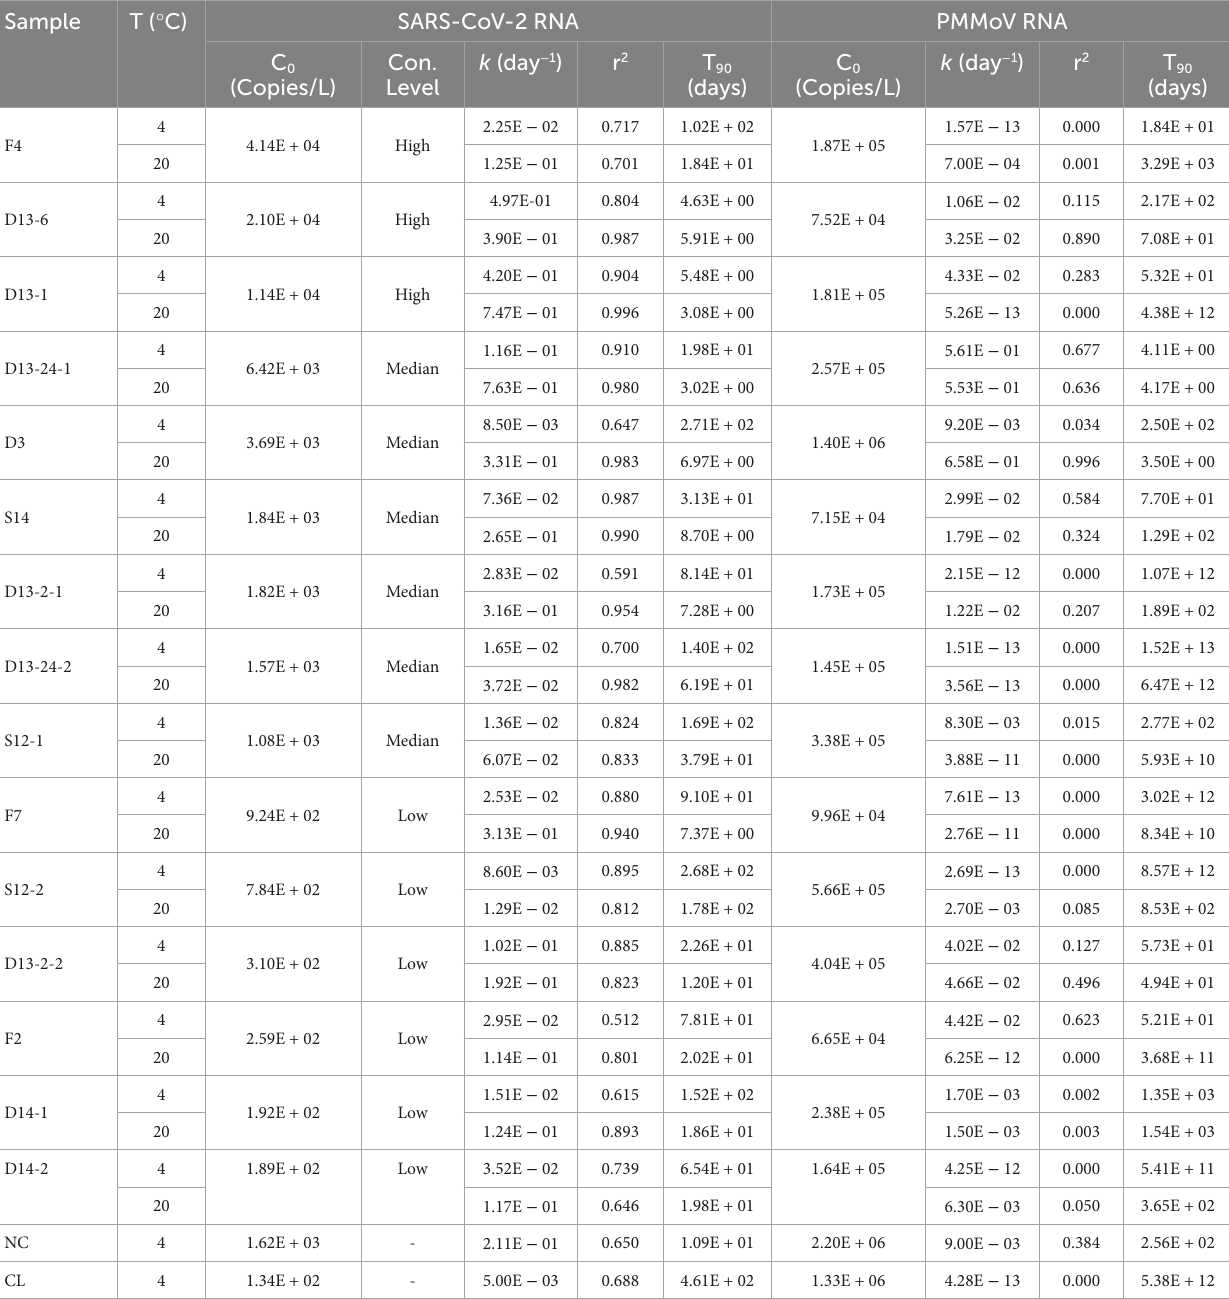
TABLE 1 The k and T 90 values of SARS-CoV-2 and PMMoV RNA in raw sewage at 4 ° C and 20 ° C.